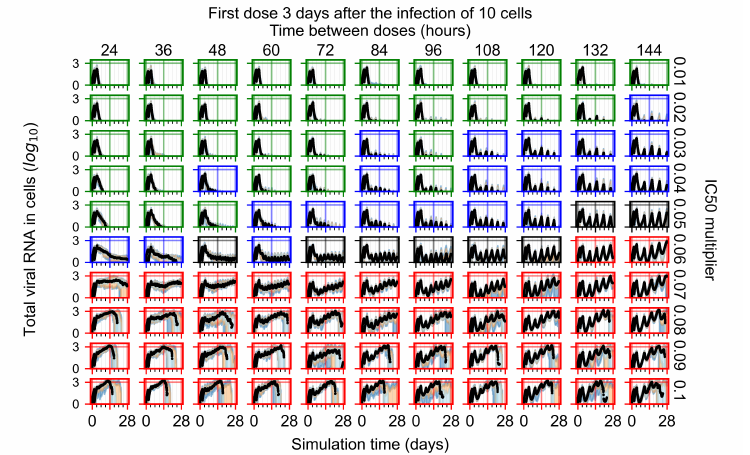
Figure A37. Amount of viral RNA in infected cells (arbitrary units), Y axis in log scale, and exponent values as tick